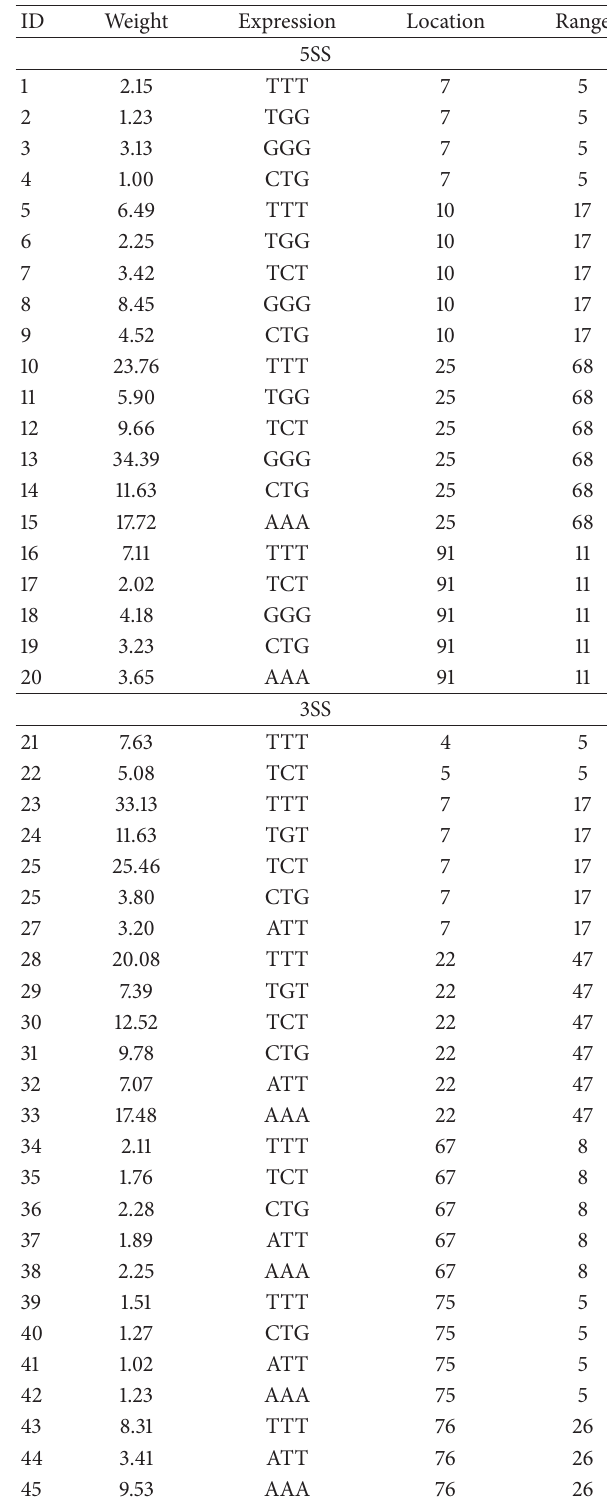
Table 1: UFPs of 5SS and 3SS.